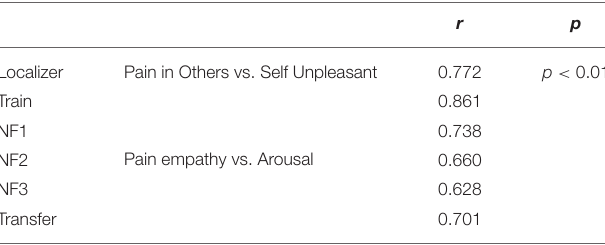
TABLE 1 | Correlation analysis of behavioral ratings of the localizer and the neurofeedback runs (independent of the assumed perspective) (r—correlation coefficient; p—statistical